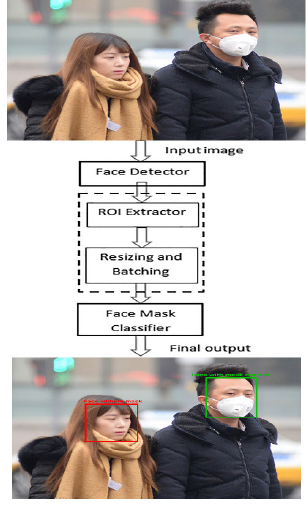
Figure 3. Steps in image augmentation for classification.